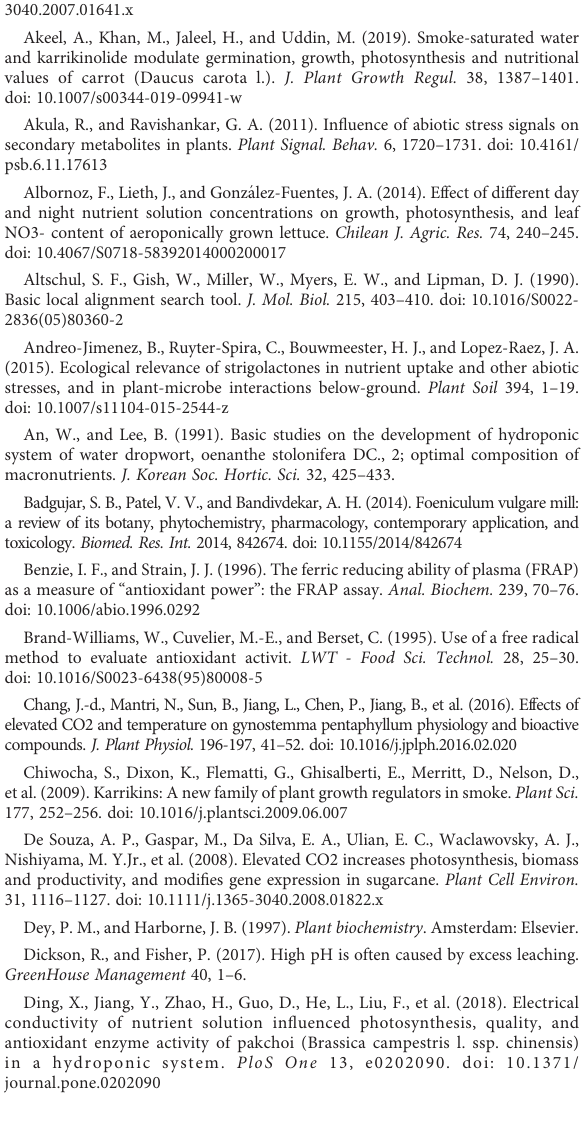
SUPPLEMENTARY FIGURE 2 RNA sequencing of CO 2 -treated fennel at 400 ppm or 800 ppm. (A) The hierarchical clustering of differentially expressed genes in the replicated samples. (B) The number of up- or downregulated genes. SUPPLEMENTARY FIGURE 3 The standard curves of total phenol, total fl avonoid, DPPH, and ferric reducing antioxidant power.